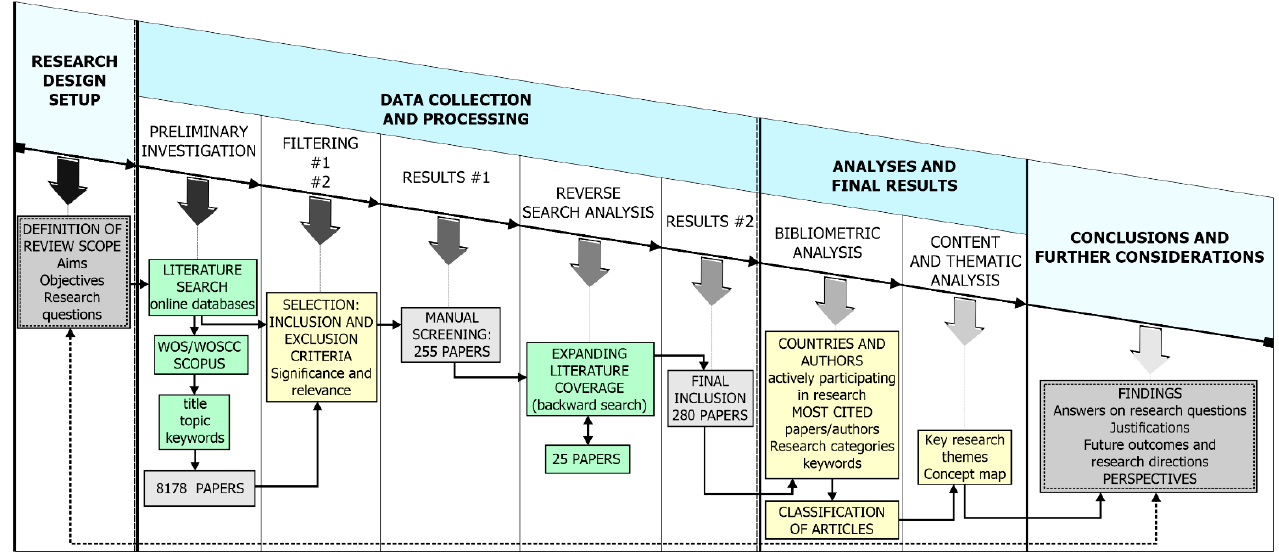
Figure 1. Research steps.